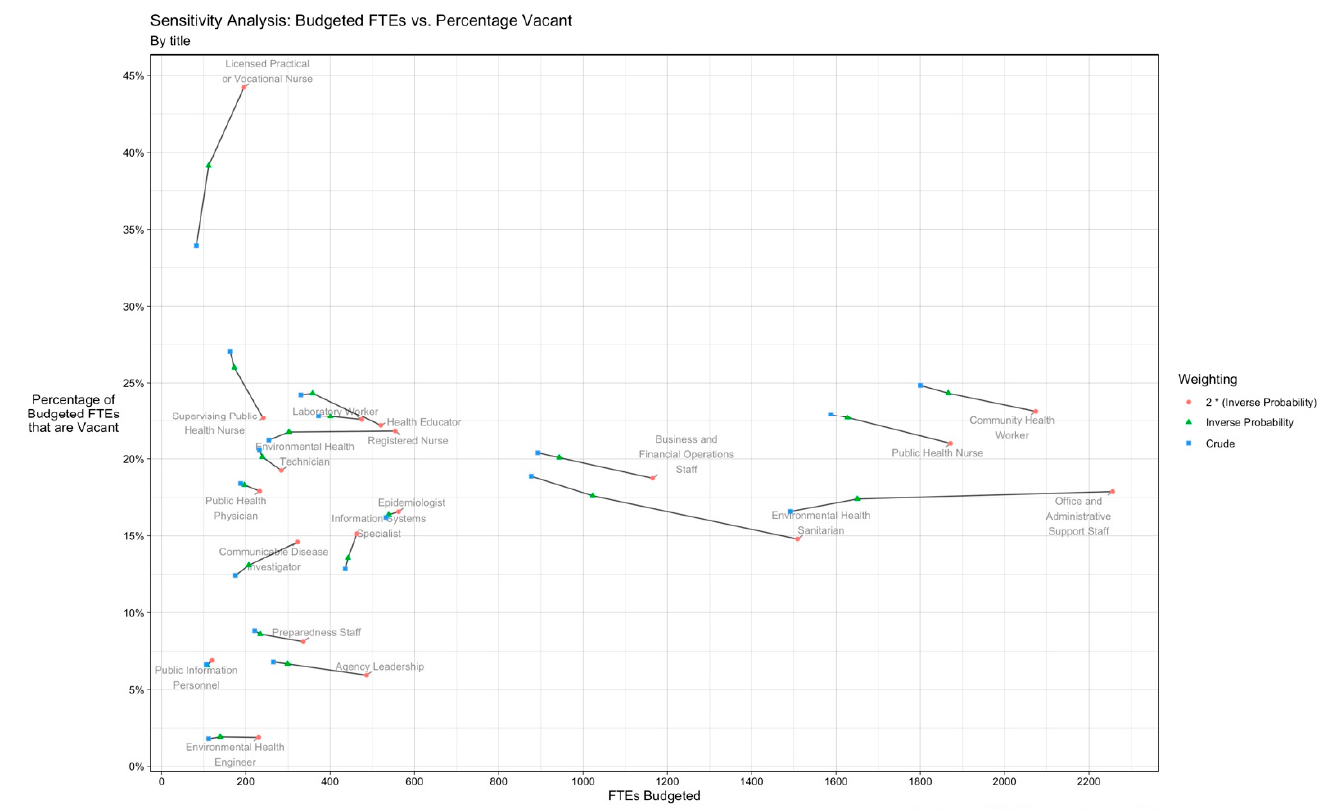
Figure A3. Sensitivity Analysis for Figure 2.